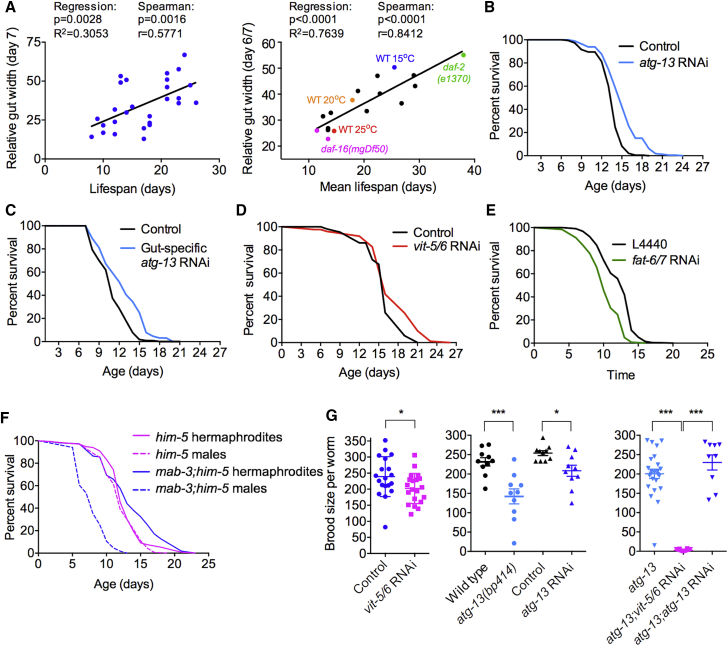
Intestinal Autophagy Promotes Optimal Reproduction at the Expense of Longevity(A) Correlation between intestinal atrophy and lifespan. Left: individual worm analysis, day 7 gut width. Right: worm population analysis, different treatments affecting lifespan, day 6/7 gut width.(B) Adult-limited atg-13 RNAi targeted to the whole animal extends lifespan; N = 6 trials.(C) Adult- and gut-limited atg-13 RNAi extends lifespan; N = 5 trials.(D) Inhibition of yolk synthesis extends lifespan; N = 5 trials.(E) Inhibition of fatty acid synthesis shortens lifespan; N = 2 trials. Previously, no effect of fat-6(tm331); fat-7(wa36) on lifespan was detected [51]; the reason for the different effects of fat-6/7 RNAi and mutation remains unknown.(F) mab-3; him-5 males are short lived but mab-3; him-5 hermaphrodites are not; N = 2 trials. Reduced lifespan of mab-3 males could be attributable to the visceral or the tail abnormalities.(G) Adult-limited vit-5/6 RNAi (left) or atg-13 RNAi and atg-13 mutation (center) each modestly reduces brood size, but combined vit-5/6 RNAi and atg-13(bp414) cause sterility (right); N = 2 trials.Experiments were performed at 20°C without FUDR (A and F), 25°C without FUDR (D, E, and G), and 25°C with FUDR (B and C). ∗p < 0.05, ∗∗∗p < 0.001. See also Figure S6 and Data S3.